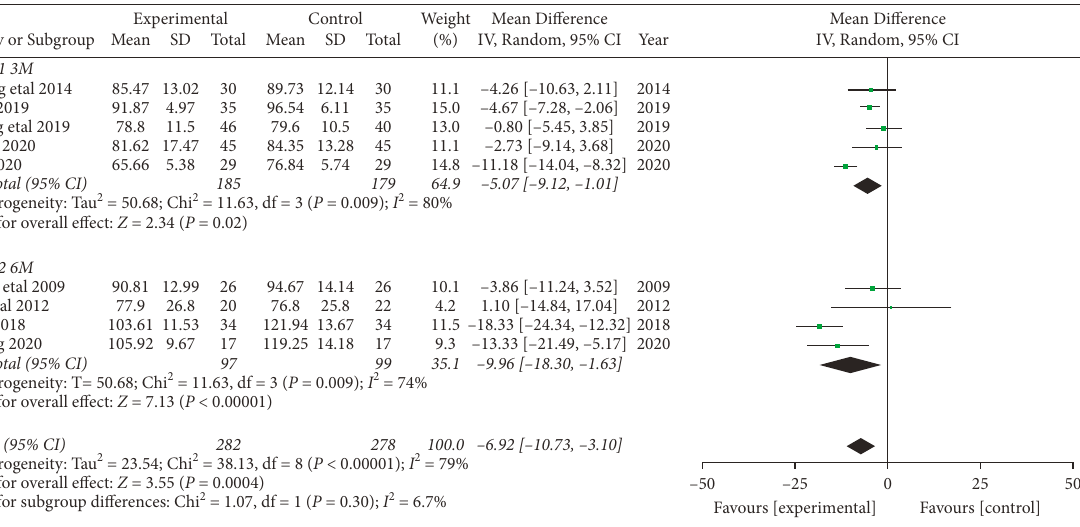
Figure 8: GTW combined with RASI versus control Scr-3 months versus 6